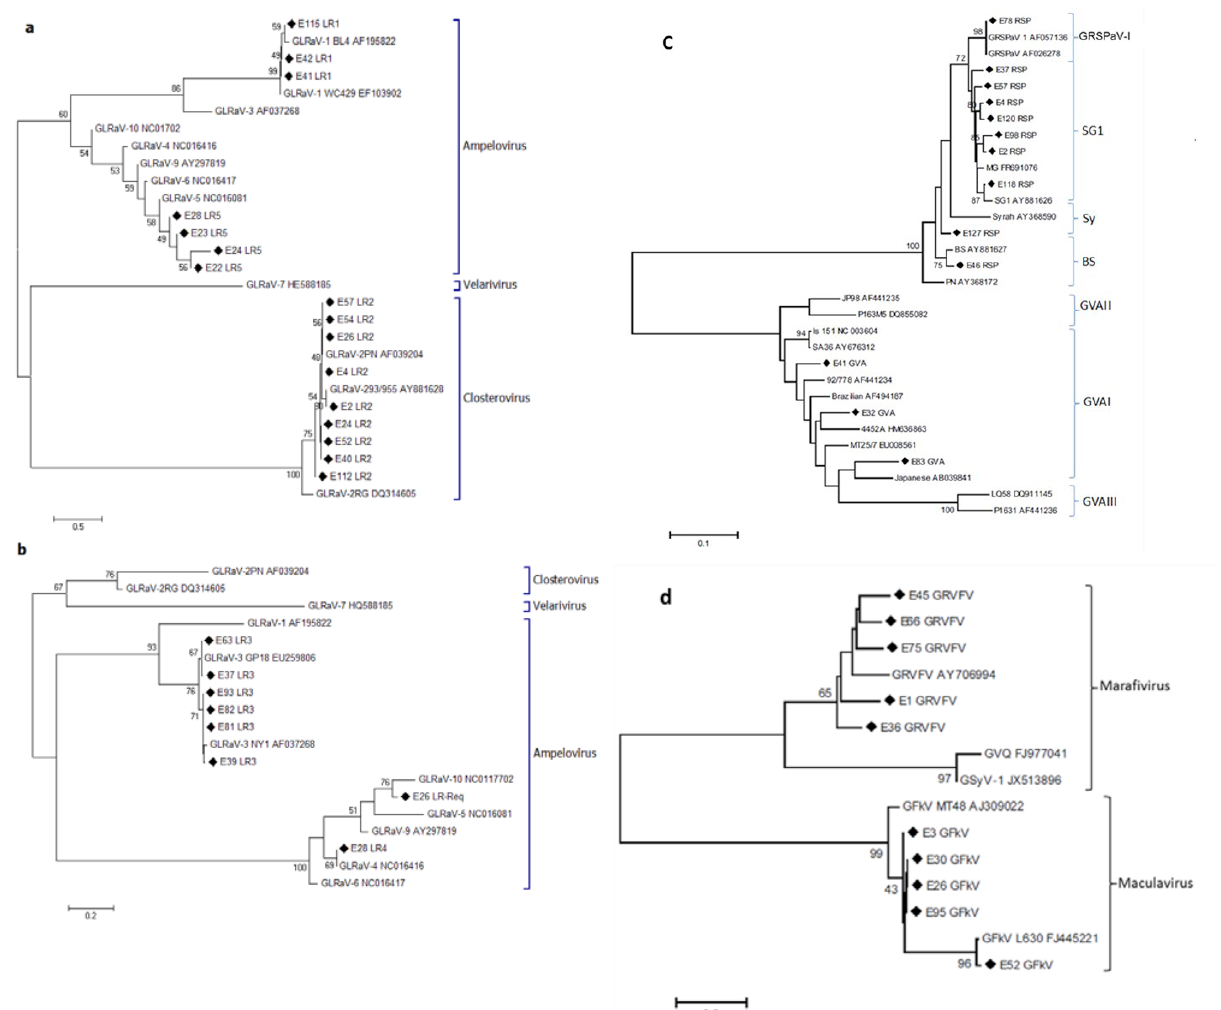
Figure 1. Neighbour-joining phylogenetic analysis of partial nucleotide sequences of viral isolates. a: CP gene analysis of Closteroviridae family viruses including GLRaV-1 (235 bp), GLRaV-2 (509 bp) and GLRaV-4 variant 5 (LR5) (534 bp) Span - ish isolates; b: HSP70 gene analysis of Closteroviridae family viruses including GLRaV-3 (501 bp), GLRaV-4 variant 4 (321 bp) and variant Req (312 bp) Spanish isolates; c: CP gene analysis of Betaflexiviridae family viruses including GRSPaV (330 bp) and GVA (396 bp) Spanish isolates; d: RdRp gene analysis of Tymoviridae family viruses including GFkV (283 bp) and GRVFV (280 bp) Spanish isolates. Numbers at nodes indicate bootstrap values of 1,000 replicates. Information about ref - erence virus isolates used to determine phylogenetic relationships is achievable by the corresponding accession number. Spanish isolates sequenced for this study are marked with ♦ and GenBank accession numbers are listed in Table